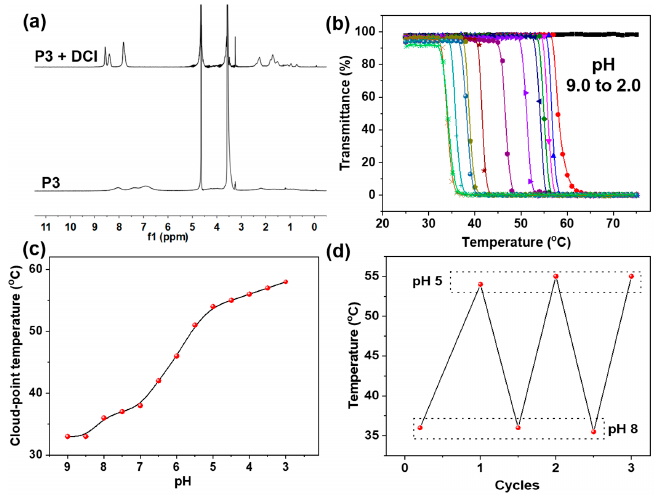
Figure 5. ( a ) 1 H NMR spectra of P3 before and after the addition of DCl in D 2 O. ( b ) Effect of pH values on the thermal-responsive behaviors of P3 in PBS buffer. ( c ) Plots of the cloud-point temperature depending on the pH values in PBS buffer. ( d ) Reversible cycles of cloud-point temperature by alternatively changing the pH between 8 and 5.